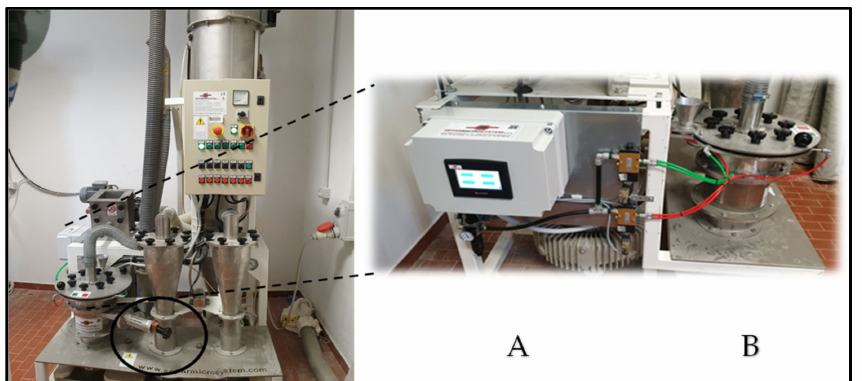
Figure 3. Air-classifier pilot plant augmented through the addition of a programmable logic controller (PLC) for the pneumatic flow management ( A ) and a chamber designed with a decreasing section ( B ). The circle indicates the setting airflow inlet valve. The F and G housings are placed below the steel plan located under the inlet valve.